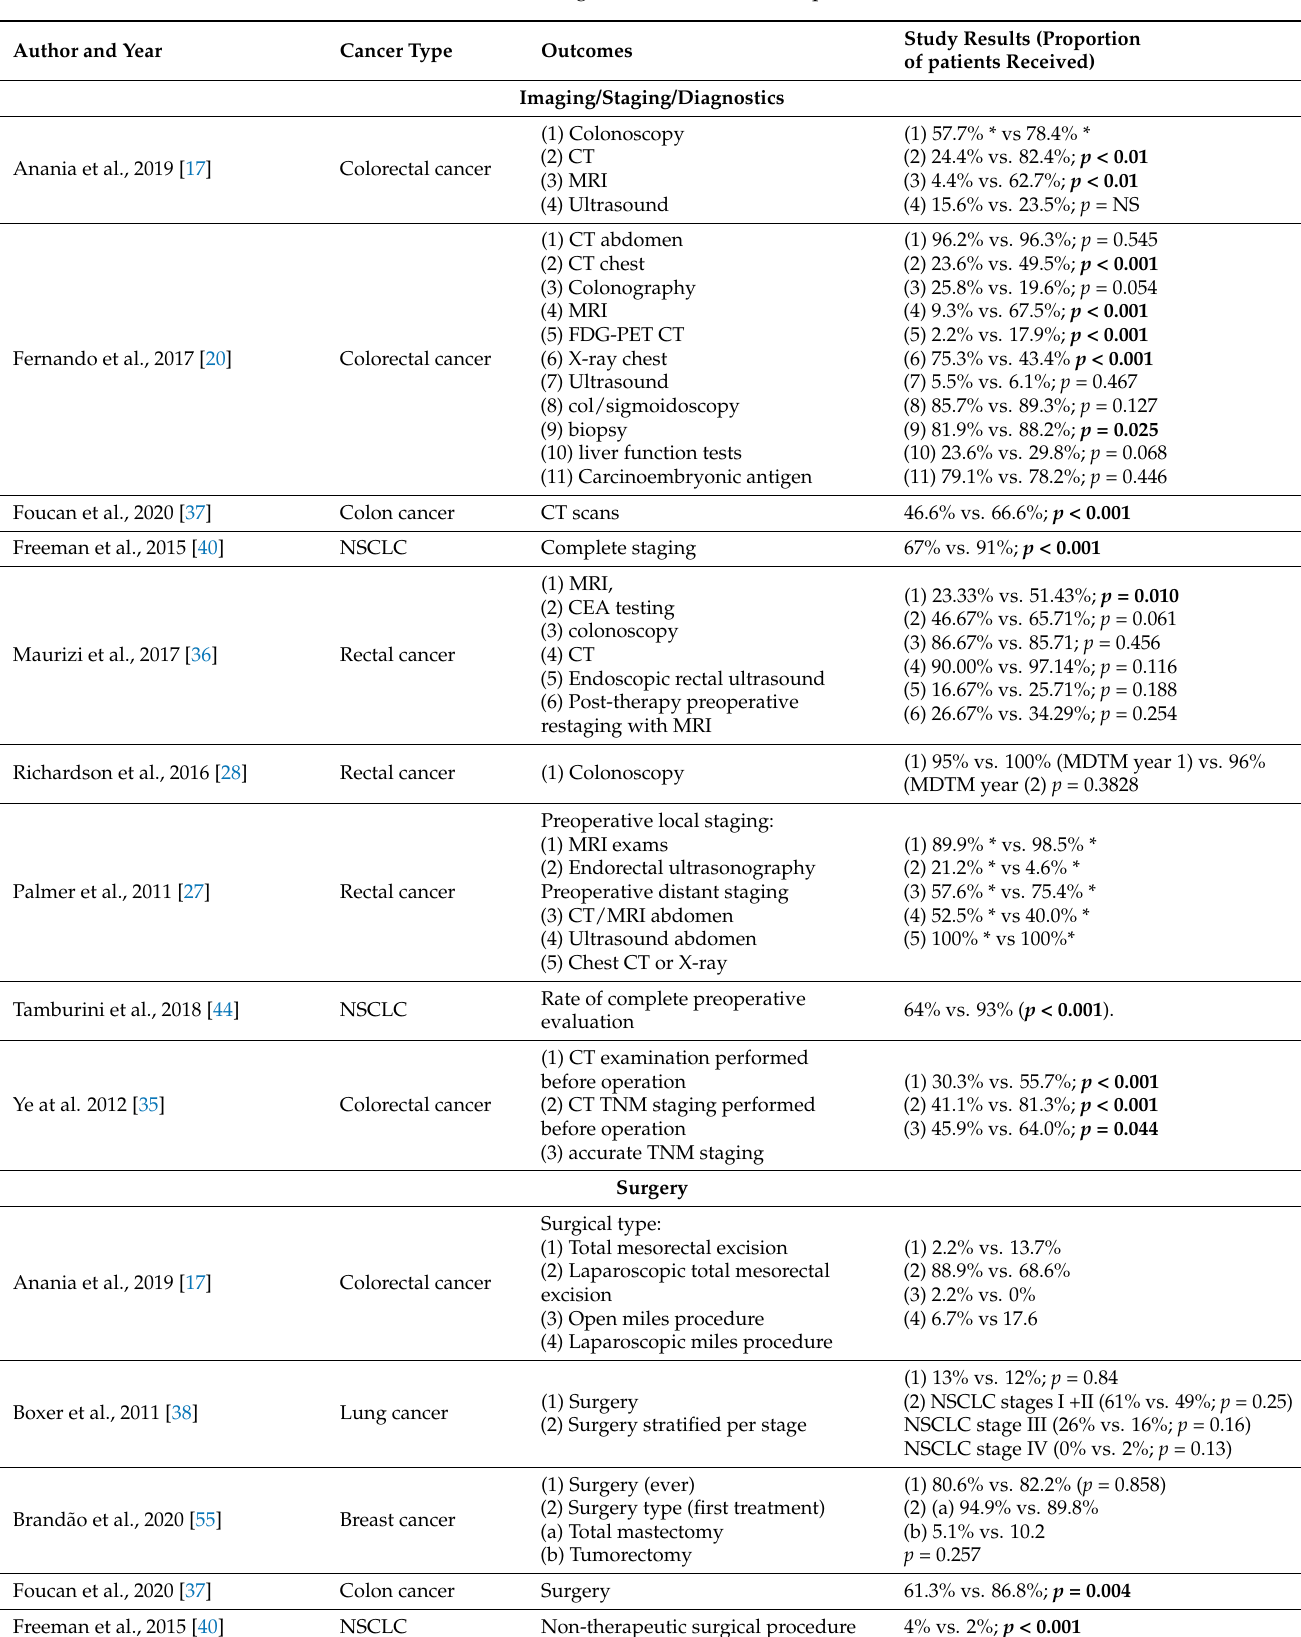
Table 4. Results for diagnostics, treatment and palliative